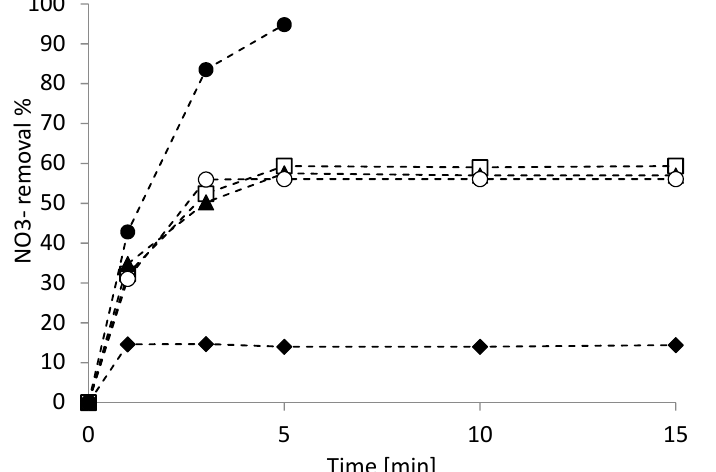
Figure 7. Nitrate removal at different pH conditions: unbuffered ( ▲ ); buffered at pH = 3 ( ● ); and initial pH = 3 ( □ ), 5 ( ○ ), and 10 ( ♦ ). Condition: T = 298 K, 0.1 g L − 1 bimetallic nanoparticles, and [NO 3 − ] = 300 mg L − 1 .